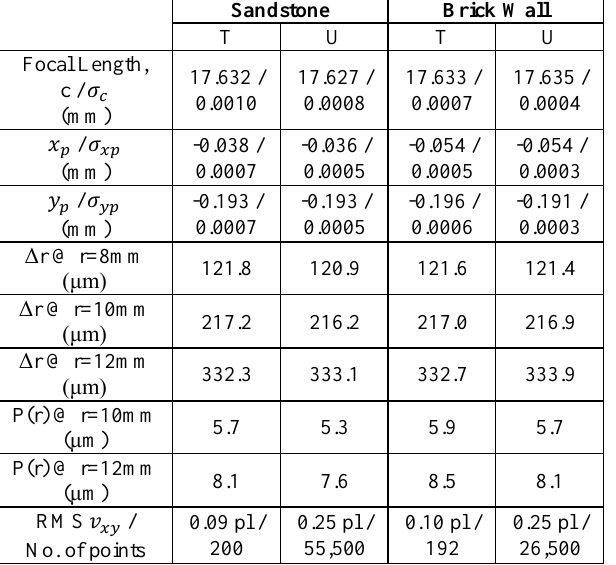
Table 3. RMS coordinate discrepancy values: Calibration 1